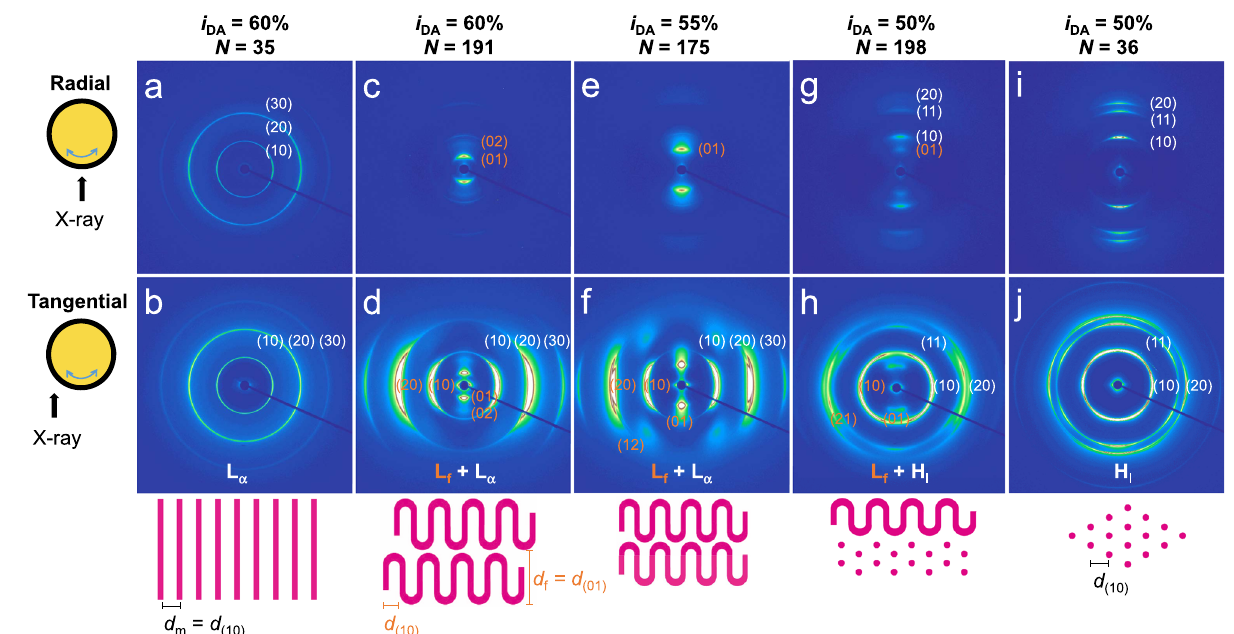
Fig. 3 2D SAXS patterns of shear-aligned polymer solutions at 64 wt% concentration. Scatterings obtained along the radial ( a , c , e , g , i ) and tangential ( b , d , f , h , j ) directions are shown. i DA and N values are indicated on top. Interpretation of the scattering patterns in real space is schematically given on the bottom, showing the hydrophobic domains in